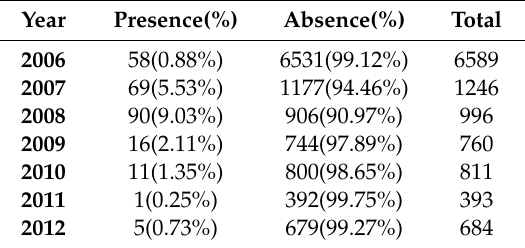
Table 1. Samples collected from field surveys from 2006 to 2012 with 250 presence points and 11,229 absence